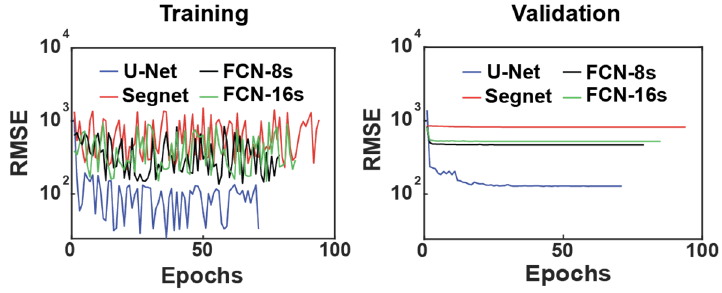
Figure 2. RMSE during